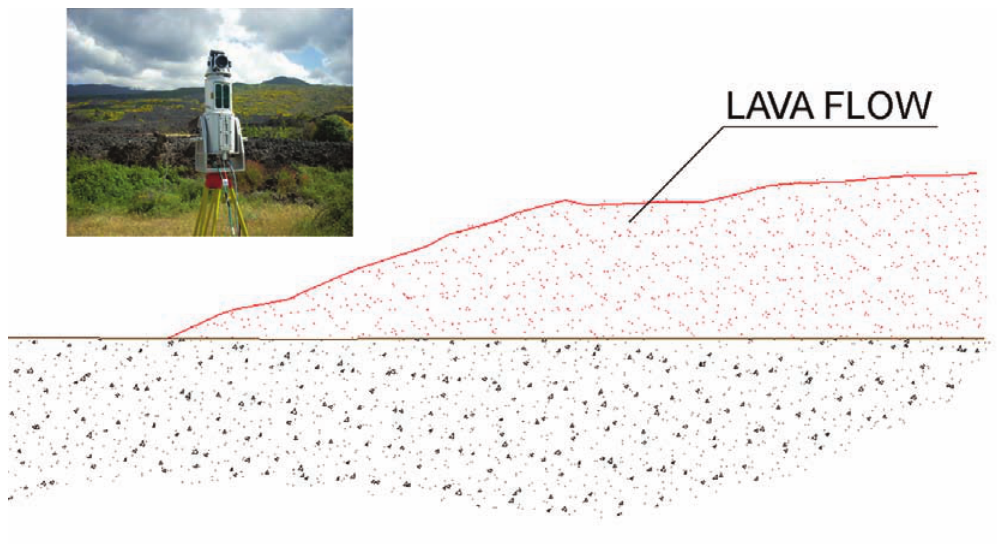
Figure 1. Laser scanner survey of the lava flow front of the 1981 Etna eruption. Red line, section cut along the 1981 lava